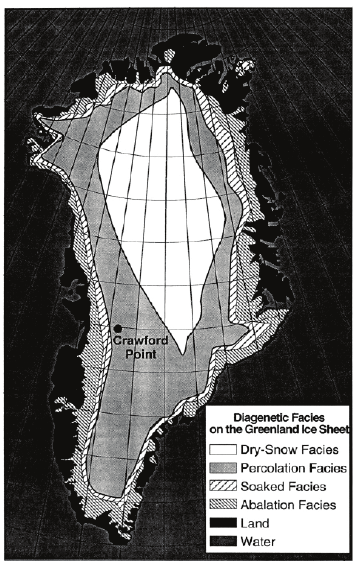
Figure 2. Snow facies of Greenland ice sheet, based on Benson (1962), from Jezek et al.,